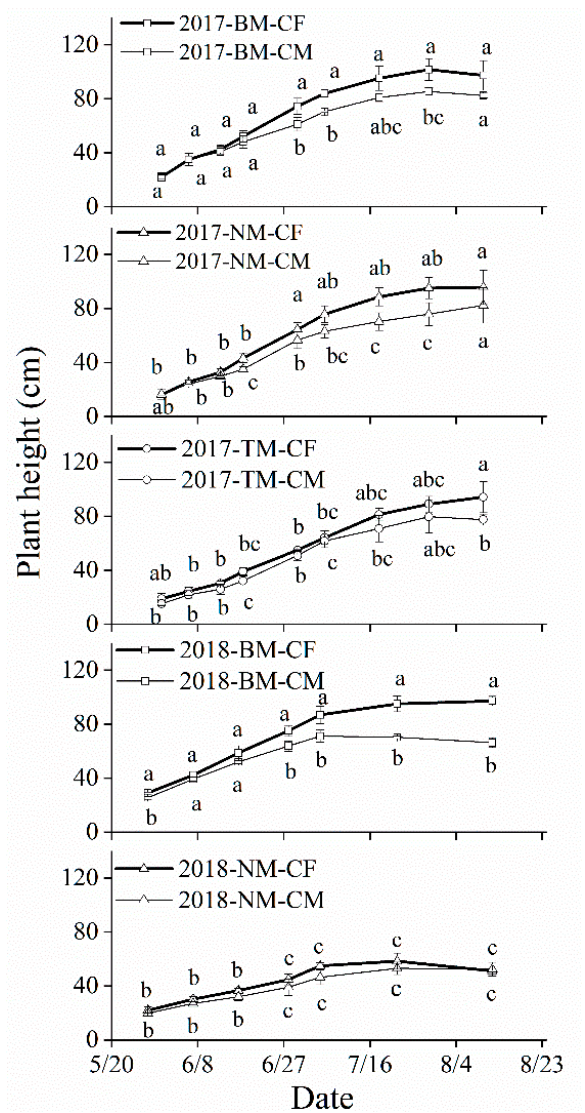
Figure 4. Plant heights for the different kinds of fertilizer and soil surface treatments: inorganic fertilizer (IF) and cattle manure (CM); black plastic-film mulch (BM), transparent plastic-film mulch (TM) and no mulch (NM) for potato production during 2017 and 2018 at Wuwei, China. Note: different letters (a, b, c and d) on points means that the differences among values with different treatments for the same date were significant at the p < 0.05 level according to the LSD test. Bars represent standard deviations ( n = 3). Values are the means of three replicates.